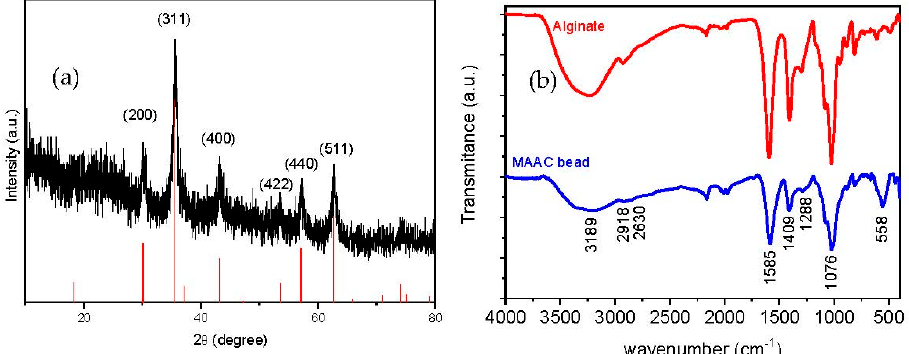
Figure 3. ( a ) X-ray diffractogram of the MAAC beads and standard XRD of Fe 3 O 4 and ( b ) IR spectra of sodium alginate and MAAC beads.